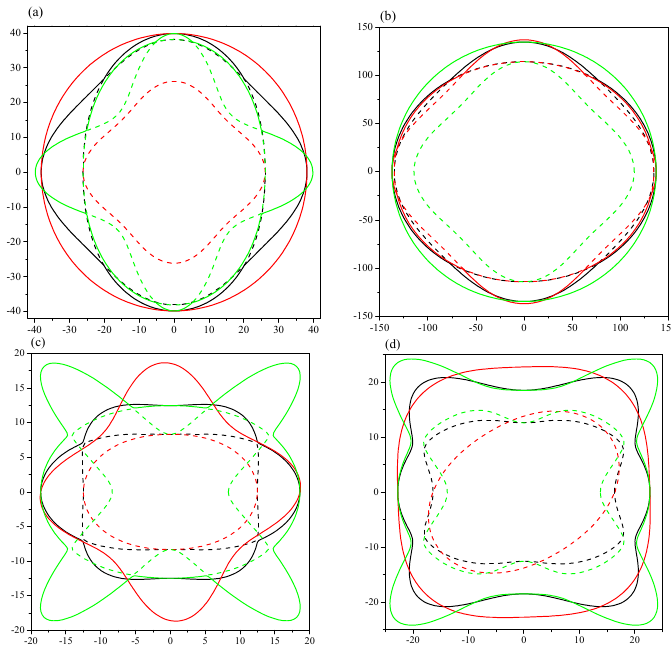
Figure 9. 2D representations of shear modulus. ( a ) Pnma -Ca 2 C at 0 GPa; ( b ) Pnma -Ca 2 C at 100 GPa; ( c ) C 2/ m -Ca 2 C at 0 GPa; ( d ) C 2/ m -Ca 2 C at 6 GPa. The solid and dash lines represent the maximal and minimal positive values, respectively. The black, red and green lines represent the xy , xz and yz planes, respectively.